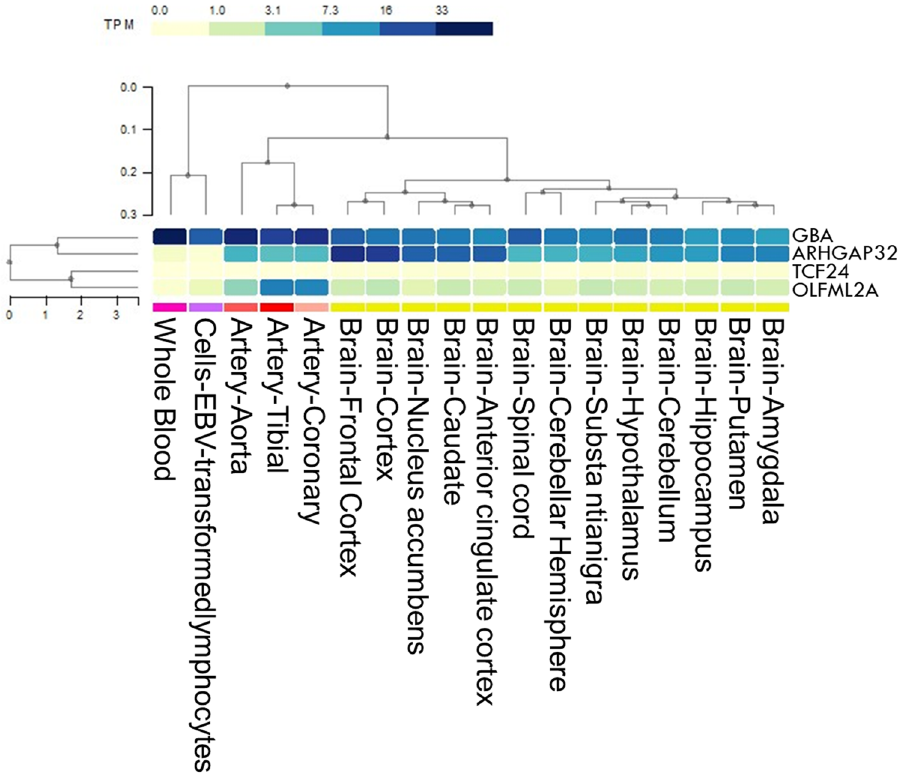
Figure 2. A heatmap of multiple gene expression involving GBA , TCF24 , OLFML2A , and ARHGAP32 in human cells and tissues including artery, brain, and whole blood is presented. Gene expression was estimated as transcripts per million (TPM). Genes and types of cells or tissues were ordered via agglomerative hierarchical clustering. An interactive heatmap specifically designed for rendering expression data was drawn by the GTEx Expression Map tool to report and summarize multi-gene and multi-tissue expressions (https:// gtexp ortal. org/ home/ multi GeneQ ueryP